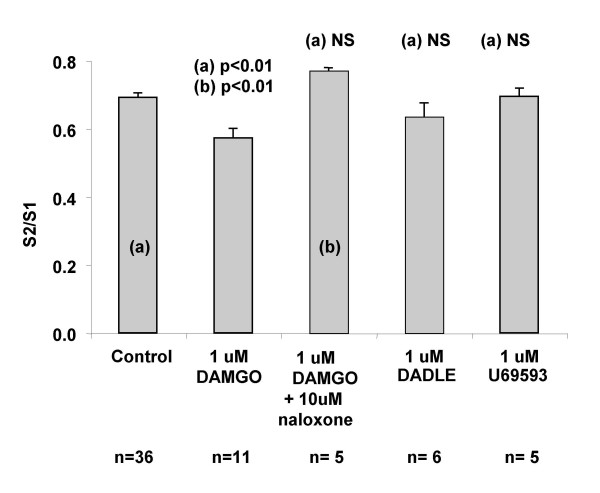
Effect of subtype-specific opoid peptides on KCl-stimulted [3H]GABA release. DAMGO, DADLE and U69593 (1 μM) were perfused as described for morphine in Figure 1. Data represent averages ± SEM. Labels on the x-axis indicate concentration of drugs present during S2. Only the μ-opioid receptor specific neuropeptide DAMGO produced a statistically significant effect (p < 0.01, One way ANOVA) on KCl-stimulted [3H]GABA release as compared to the controls (a) where no opiate drug was used. The effect of DAMGO was antagonised by 10 μM naloxone which was perfused from one fraction before the perfusion of DAMGO (b).